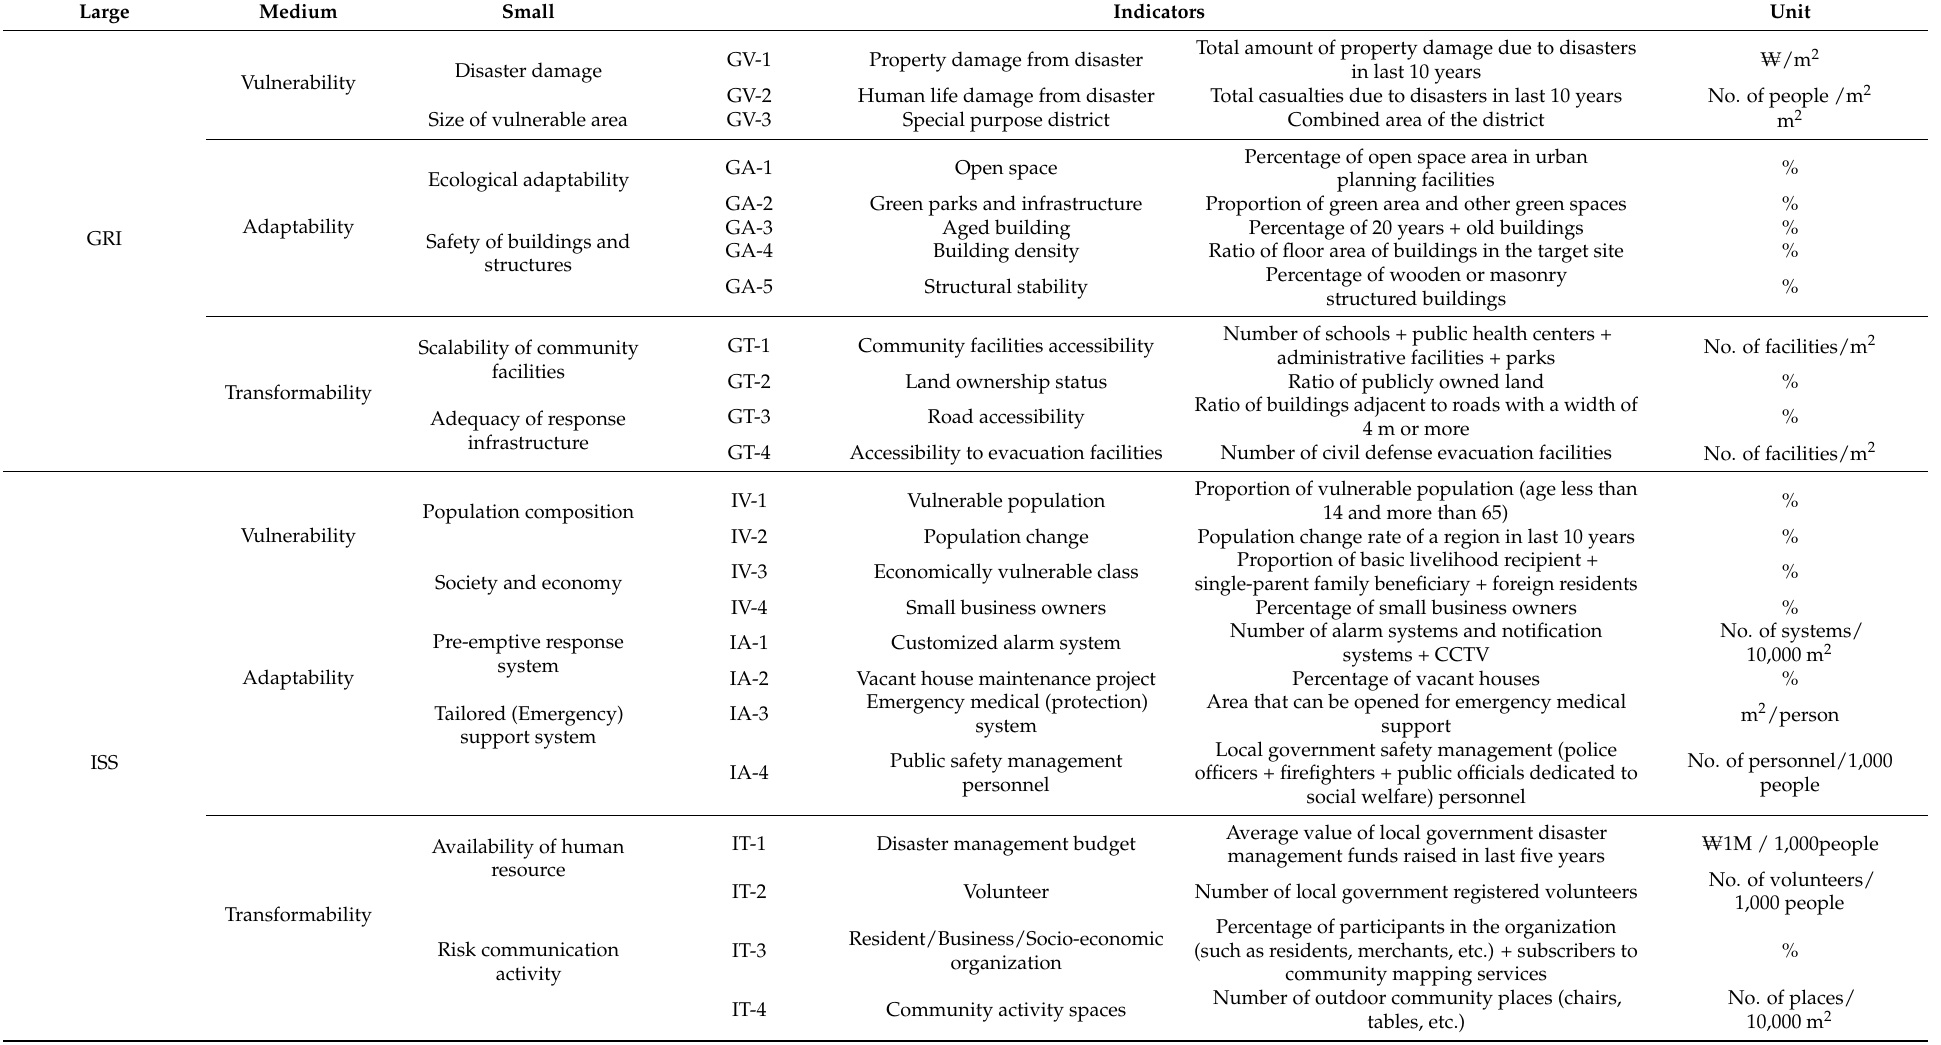
Table 2. The urban resilience evaluation